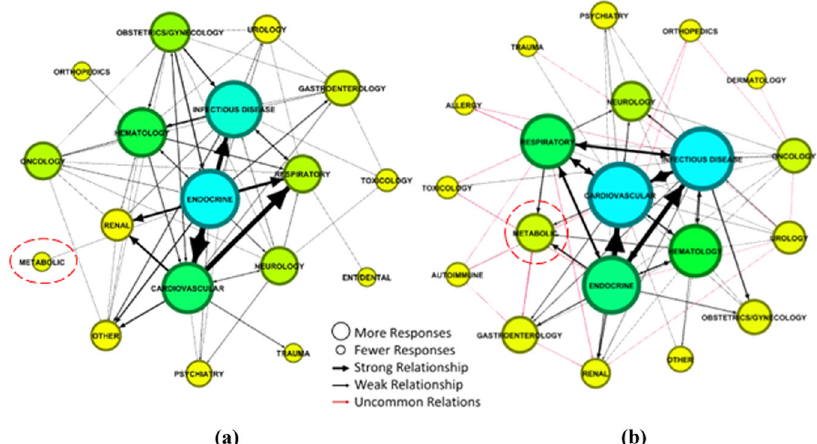
Fig. 1 Network analysis of healthcare professional perceptions of the medical conditions for which POCTs would be most helpful to diagnosis a disease. a Before COVID-19, healthcare professionals identi fi ed endocrinology as the condition for which POCTs was most helpful for making a medical diagnosis. b During COVID-19, healthcare professionals were focused more on using POCTs for diagnosing infectious